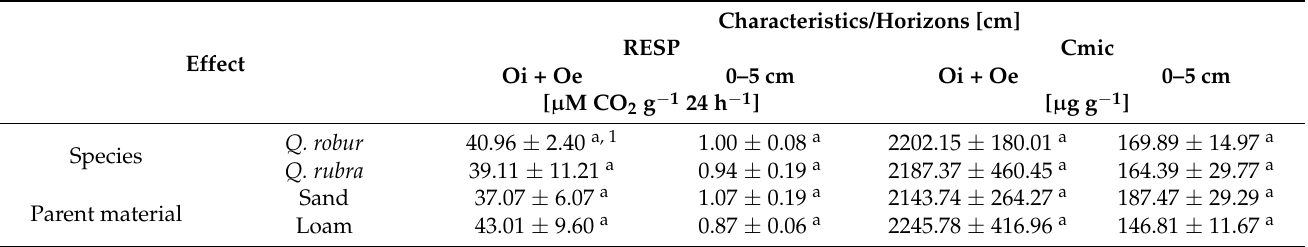
Table 3. Microbial properties (Cmic and RESP) in post-fire soils under the influence of two oak species.